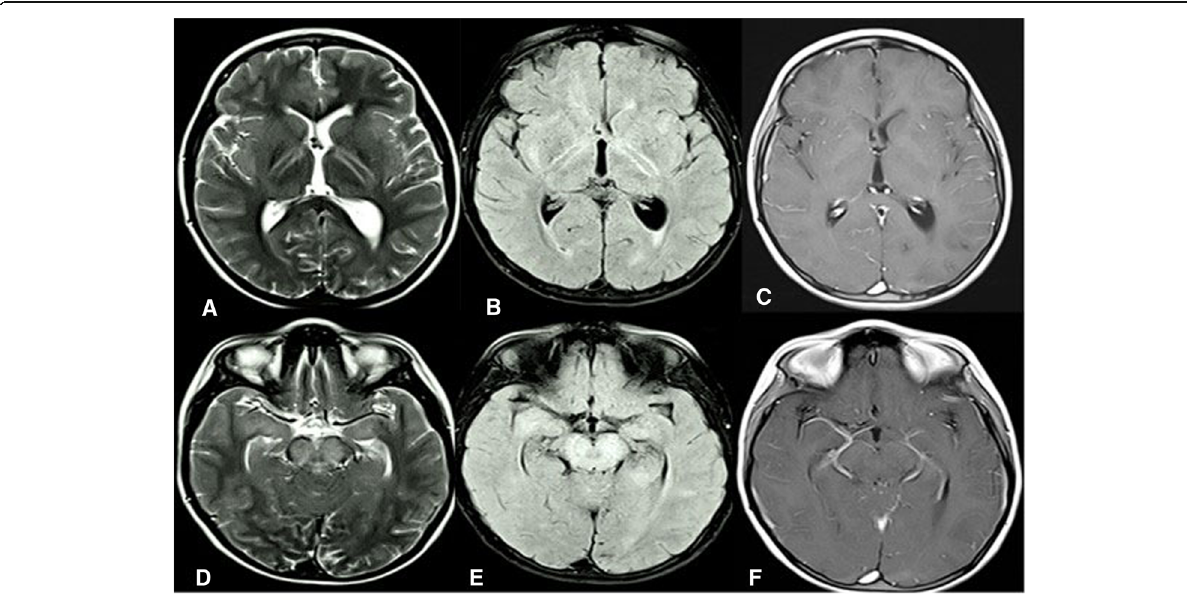
Fig. 6 CT and MRI examinations of a 12-year-old post-autologous HSCT patient presenting with impaired conscious. a , b , d & e : Axial non- contrast-enhanced T2 images ( a & d ) and FLAIR images ( b & e ) revealing brain stem, bilateral internal and external capsules altered high signal in T2 & FLAIR images. c & g Axial post-contrast study showing no evidence of post-contrast enhancement at the areas of altered signal. The patient was diagnosed with osmotic demyelination syndrome based on the imaging findings as well as the laboratory finding of low sodium (Na)